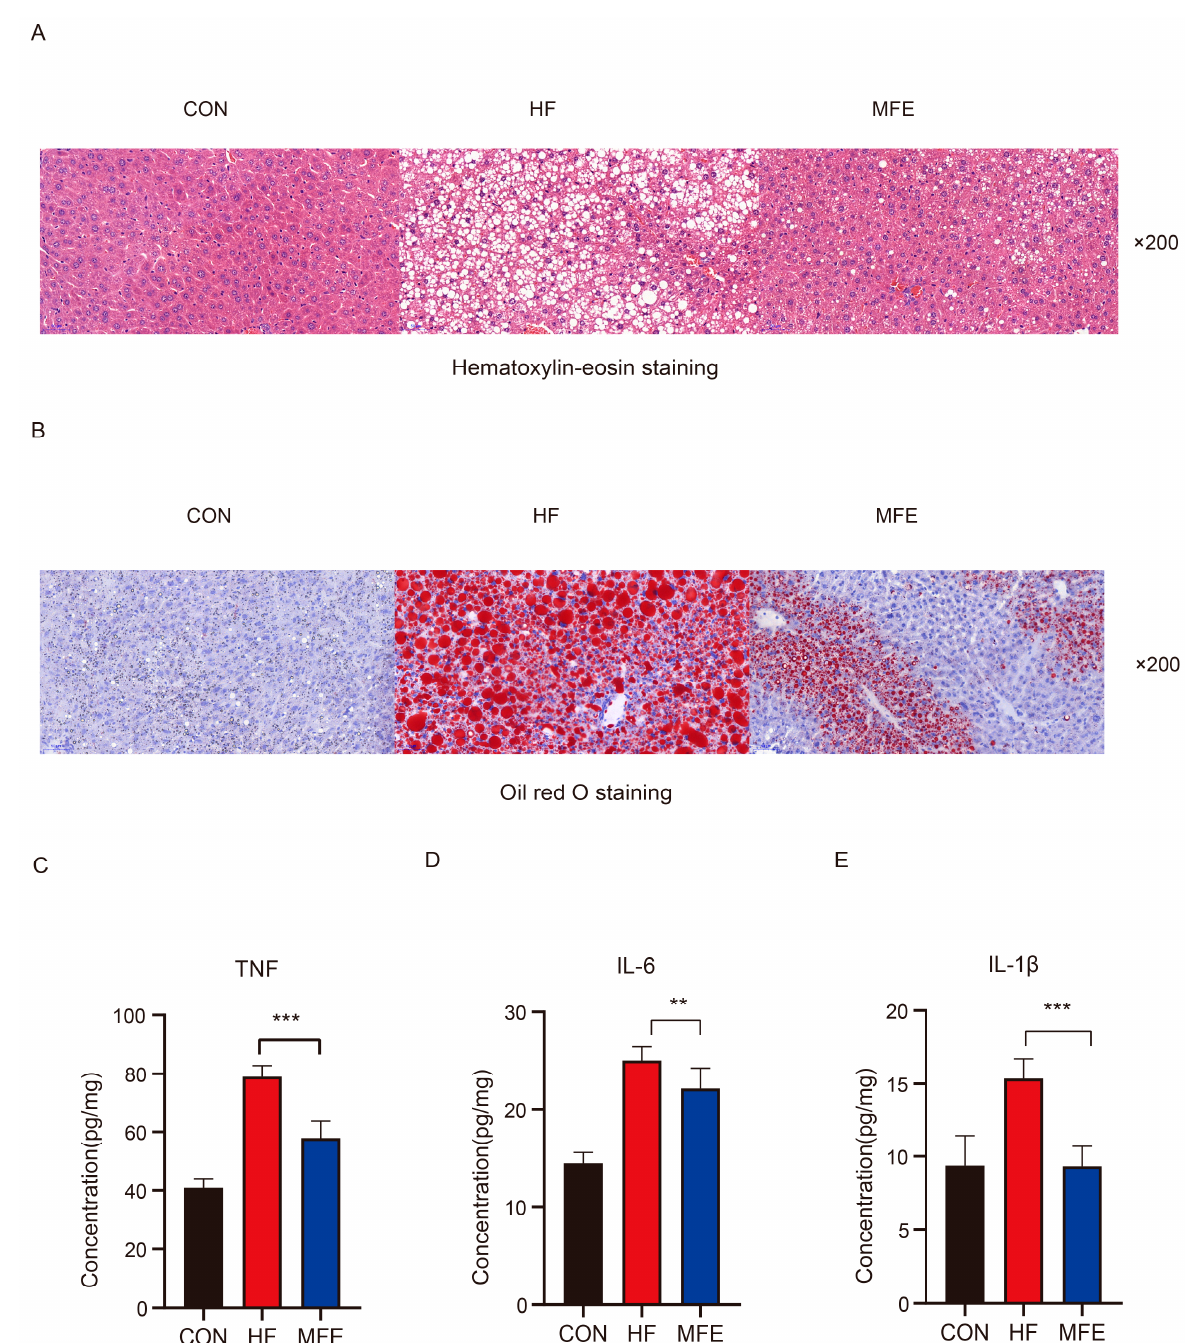
Figure 1. Effects of MFE on hepatic lipid accumulation and inflammatory factor levels in high ‐ fat ‐ diet mice. ( A ) Hematoxylin ‐ eosin staining (H&E) of mice liver section, 200× magnification. ( B ) Oil Red O staining of mice liver section, 200× magnification. ( C ) Concentration levels of TNF ‐α in the liver. ( D ) Concentration levels of Il ‐ 6 in the liver. ( E ) Concentration levels of IL ‐ 1 β in the liver. Data are shown as mean ± SD. (For each group, n = 10, ** p < 0.01; *** p < 0.001).